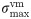
Boxplots comparing dmax, σmaxvm, RPI, PRRI and ℙrupt for the asymptomatic and symptomatic/ruptured group.The plots illustrate the interquartile range (green and red color) including the sample median as well as the first and third quartiles. Whiskers indicate minimum and maximum values and black dots represent all values from the respective group.